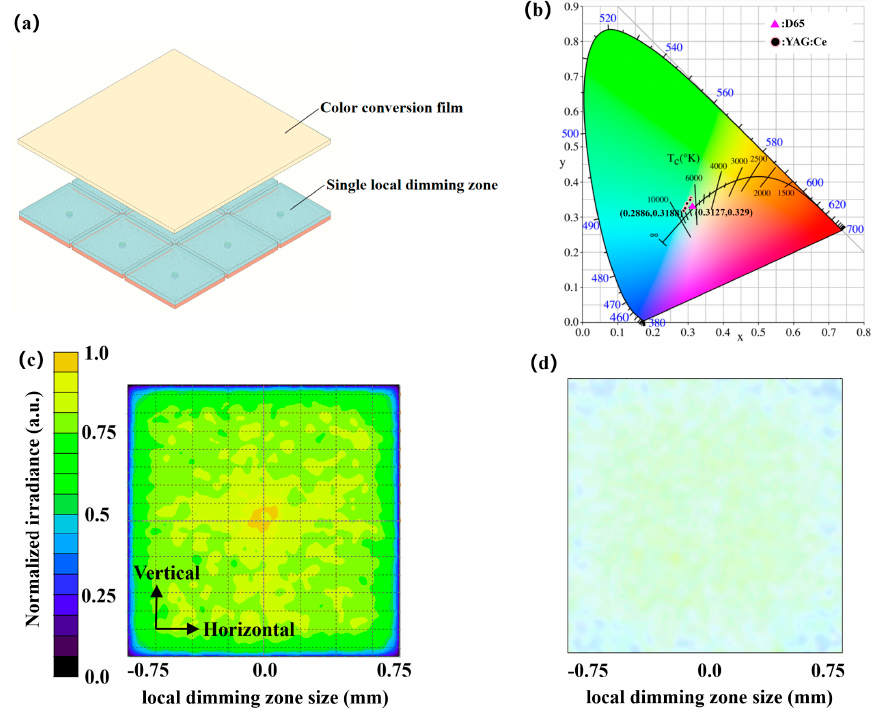
Figure 5. ( a ) Schematic of the zero-optical-distance mini-LED backlight for white balance; ( b ) Simu- lated color coordinates of the nine points in CIE 1931 color space; ( c ) 2D irradiance map; ( d ) A true color map. Table 1. CIE 1931 color coordinates of the nine points.